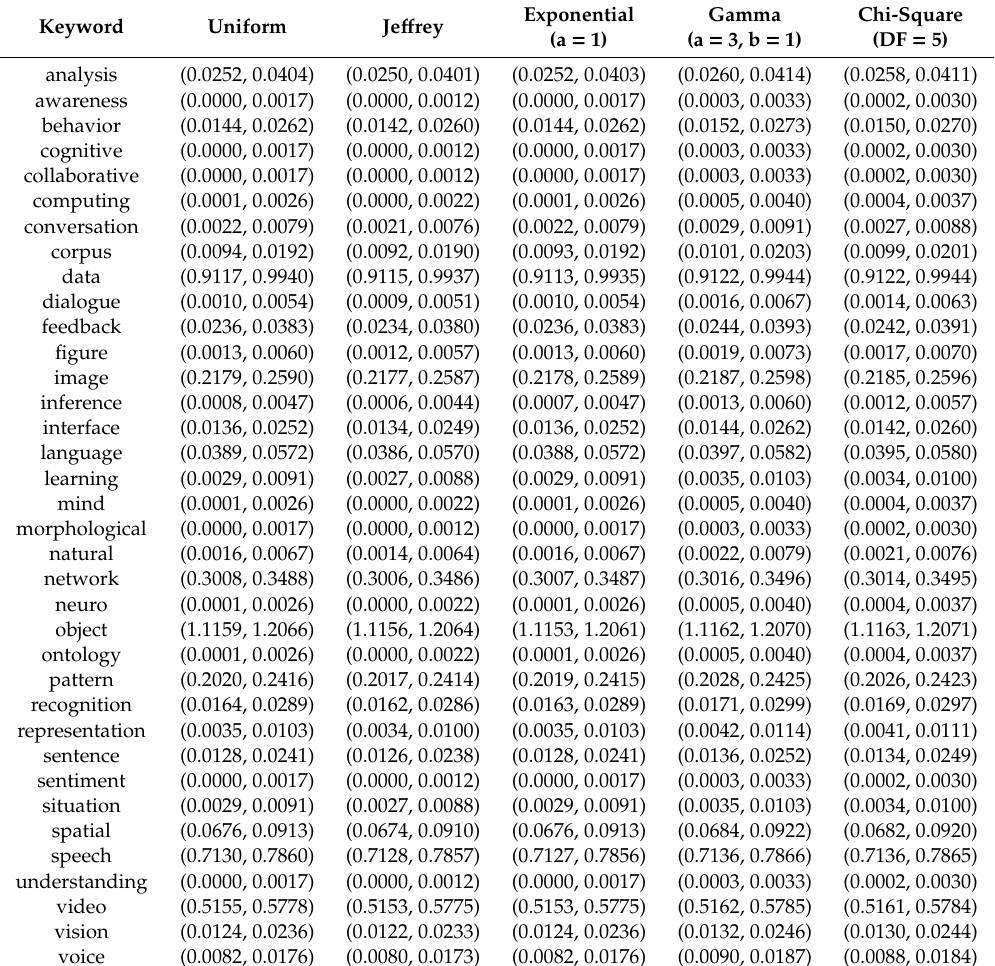
Table 4. Bayesian prediction intervals: